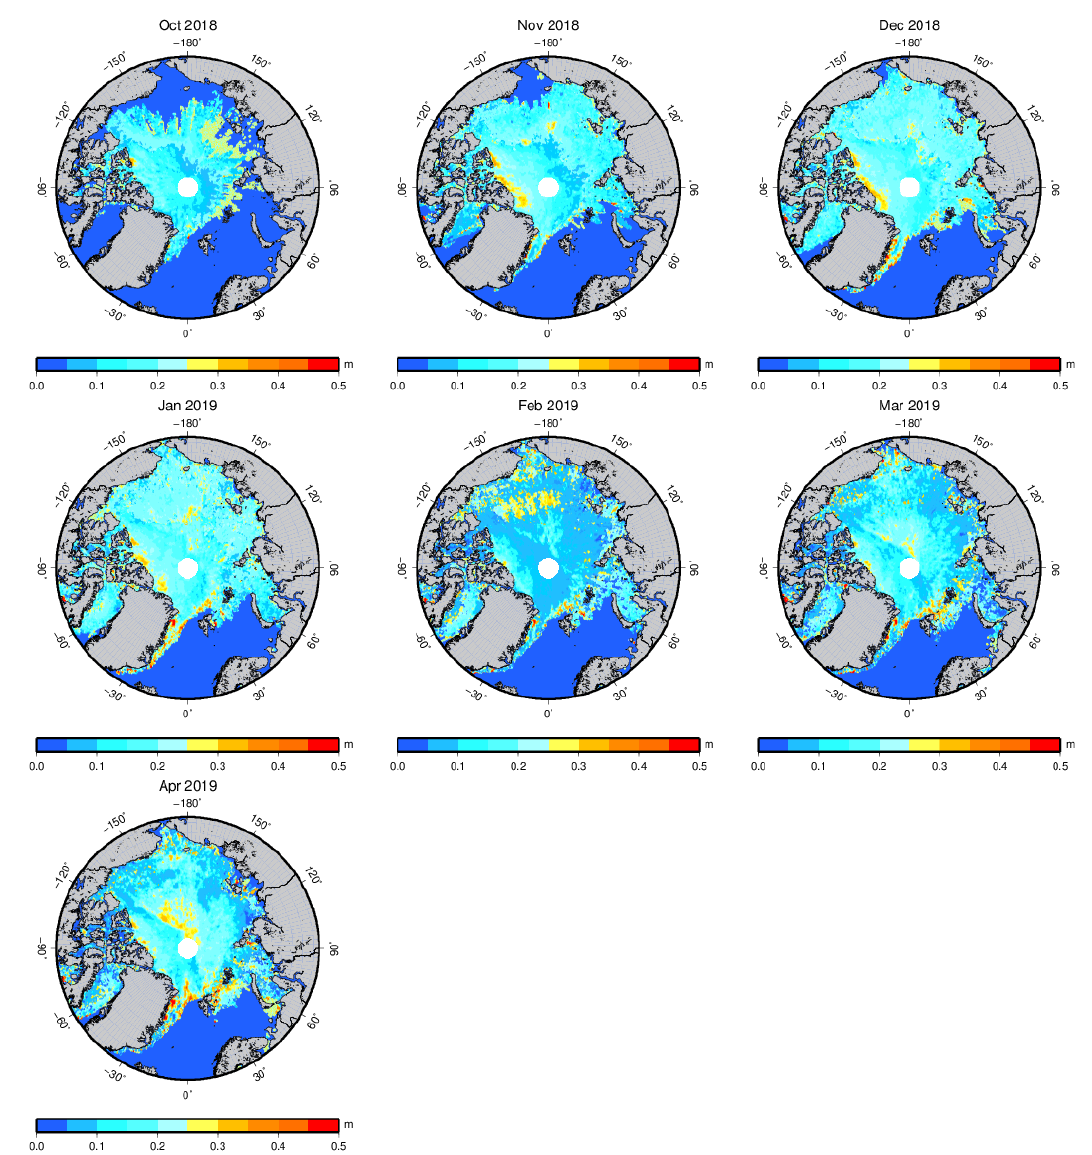
Figure 3. Arctic sea ice thickness estimation uncertainty with the LSA method for the 2018–2019 Arctic sea ice growth season from October to April.